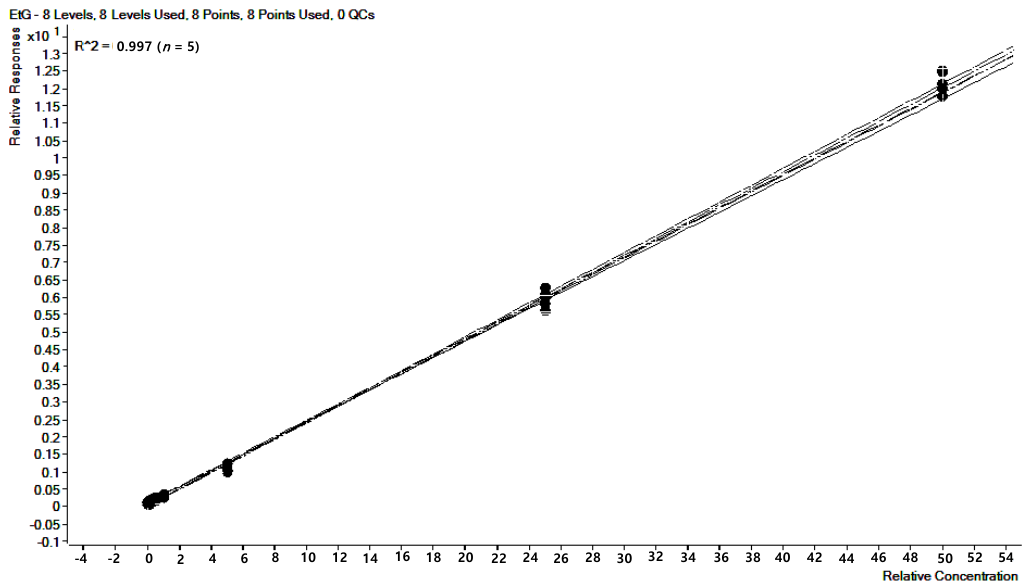
Figure 3. Overlay of regression lines prepared from different hair matrices ( n = 5).